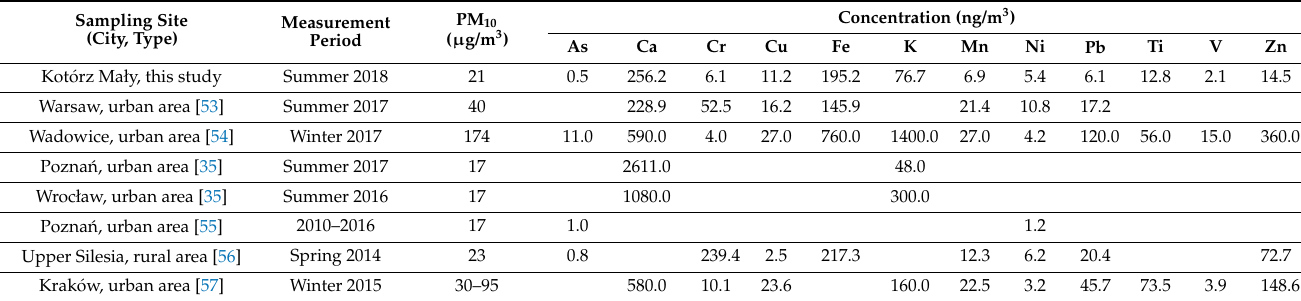
Table 2. The mean concentrations of PM 10 and PM 10 -bound elements at various sites in Poland. Sampling Site (City, Type)